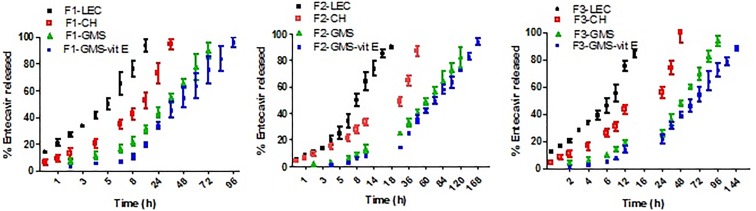
In vitro release profile of drug from different lipid polymer hybrid nanoparticles.In vitro E release from F1 prepared using LEC, LEC-CH, LEC-GMS and vitamin E coated LEC-GMS as lipid shell (A), F2 prepared using LEC, LEC-CH, LEC-GMS and vitamin E coated LEC-GMS as lipid shell (B), F3 prepared using LEC, LEC-CH, LEC-GMS and vitamin E coated LEC-GMS as lipid shell (C) after exposure to 50% final concentration rat serum. E release was measured by dialyzing each formula against PBS (pH 7.4). Drug concentration in the dialysate was quantified by HPLC. Data point represents mean and SD (n = 3).